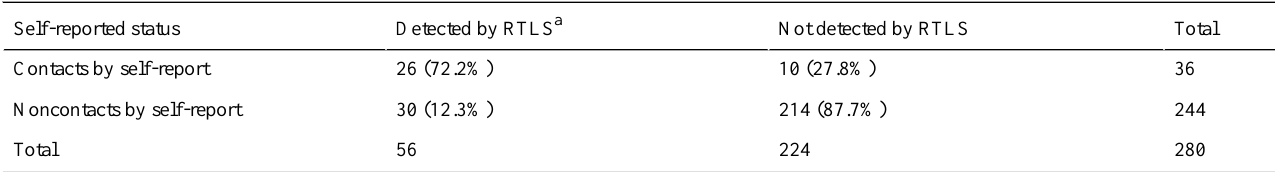
Table 2. Comparison of the performance of RTLS-based contact tracing with self-reported contacts with patients with COVID-19. Percentages are calculated according to row values.